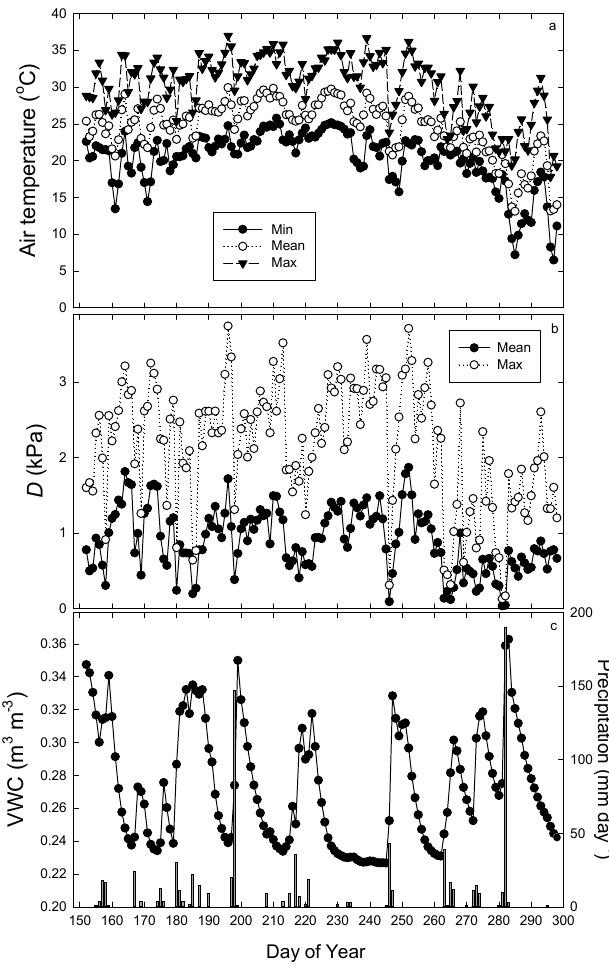
Figure 1. Mean, minimum, and maximum daily air temperature ( a ), mean and maximum daily vapor pressure deficit ( D , kPa) ( b ), and daily mean volumetric water content (VWC) and precipitation ( c ) during the study period.